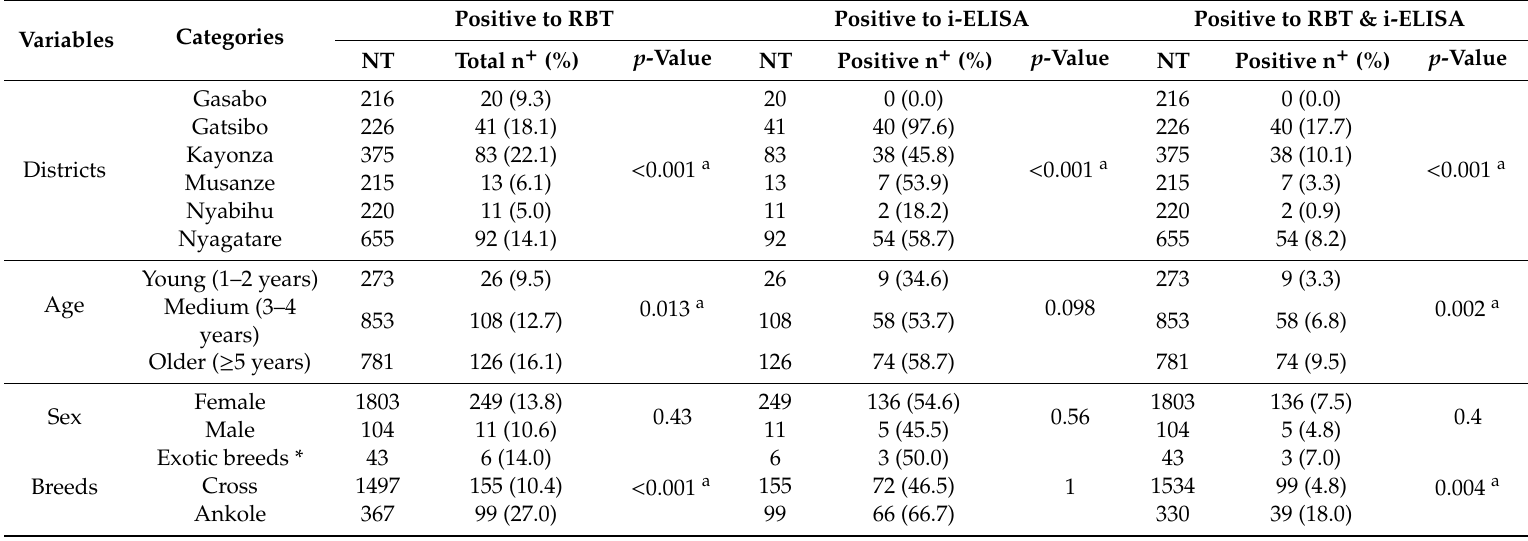
Table 1. Results of descriptive and univariate analysis between potential individual animal risk factors and the serological status of brucellosis in cattle sampled at the wildlife-livestock-human interface in Rwanda. Positive to RBT Positive to i-ELISA Variables Categories